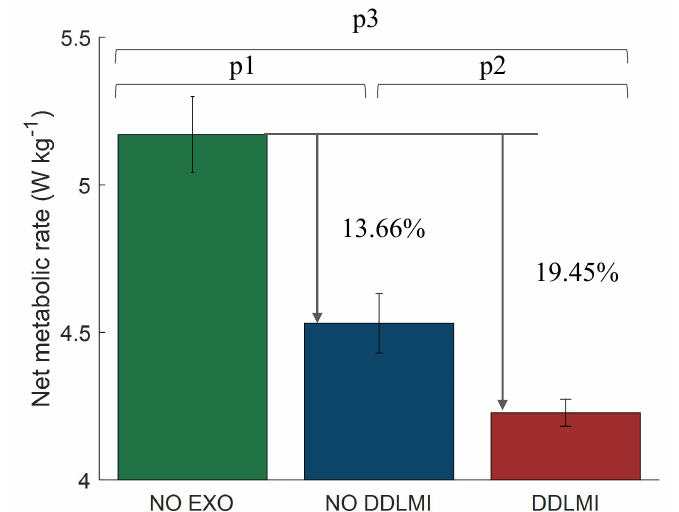
Figure 12. The metabolic reduction when walking on different terrains. The NO EXO, NO DDLMI, and DDLMI present the case of not wearing soft exoskeleton, and wearing exoskeleton with and without the DDLMI method. p1, p2, and p3 are the results of two-side t-tests, which are 0.0015, 0.009, and 0.0002,